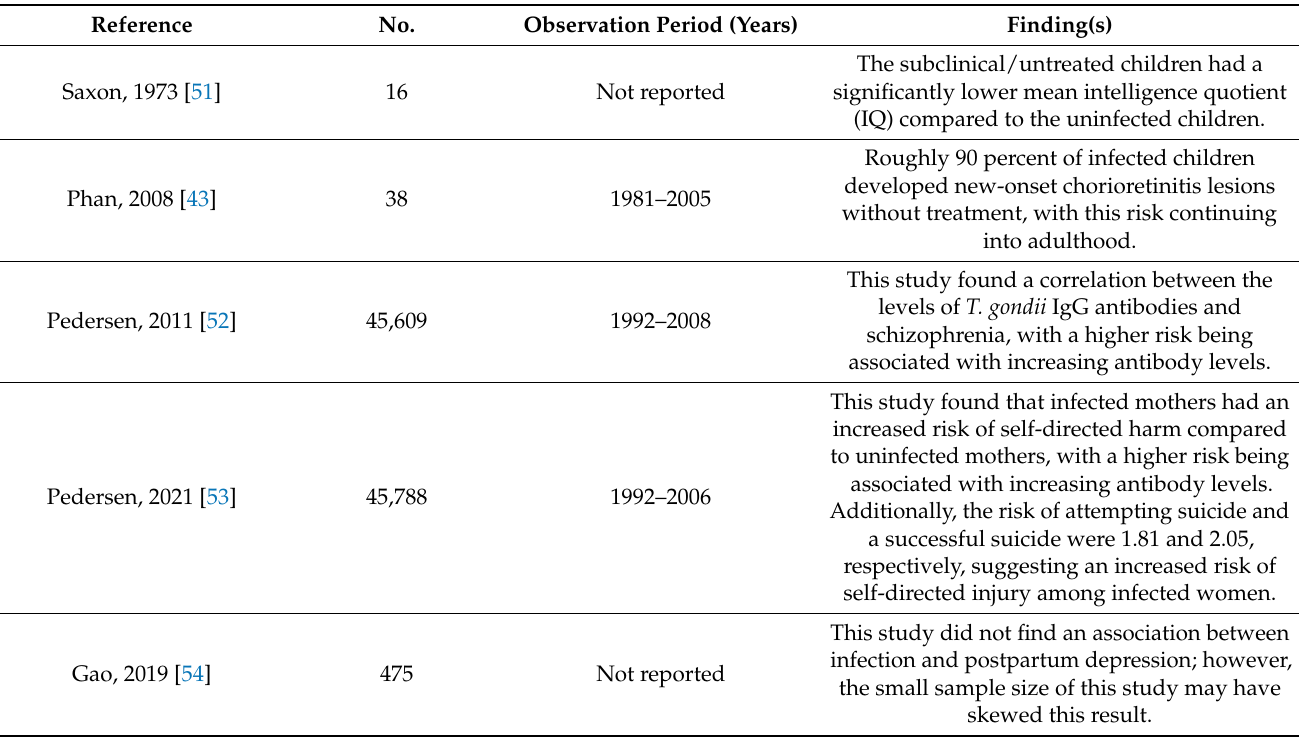
Table 2. Summary of studies where toxoplasmosis was not